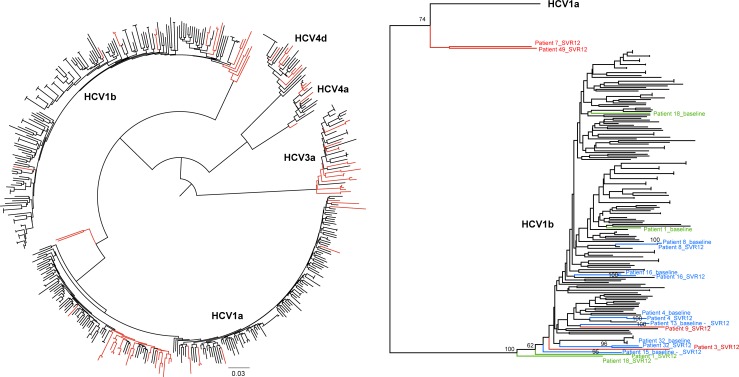
Maximum-likelihood tree of the concatenated alignment covering genetic regions NS5A and NS5B.Both the entire phylogenetic tree (left) and the HCV1b clade in detail (right) are visualized. Patient 18, coloured in green, is a clear example of reinfection with a different HCV strain, since although both viruses at baseline and at time of SVR12 evaluation are classified as HCV1b, they cluster in a different clade in the tree, with a bootstrap support of 100% for the segregation of the different clades. For patient 4, coloured in blue, both strains cluster together with a high bootstrap support (100%), suggesting that this patient experienced a virological relapse. Bootstrap replicates are only visualized for patients who experienced a relapse, all indicated in blue. Patients for which only a baseline or SVR12 evaluation sequence is included in the NS5A-NS5B alignment, are coloured in red. The sequence at time of SVR12 evaluation and baseline for patients 7 and 49 respectively, cluster outside the large HCV1b clade, which might be due to a potential event of recombination. However, detailed analyses with TreePuzzle and RDP4 for all 53 patients, could not support a recombination event. The in-depth Simplot analysis for patients 7 and 49 showed that both strains were classified as HCV1a. Despite the absence of evidence of recombination, we did not draw any conclusions concerning the occurrence of reinfection or relapse for patient 7. The bar at the bottom represents the number of nucleotide substitutions per site.